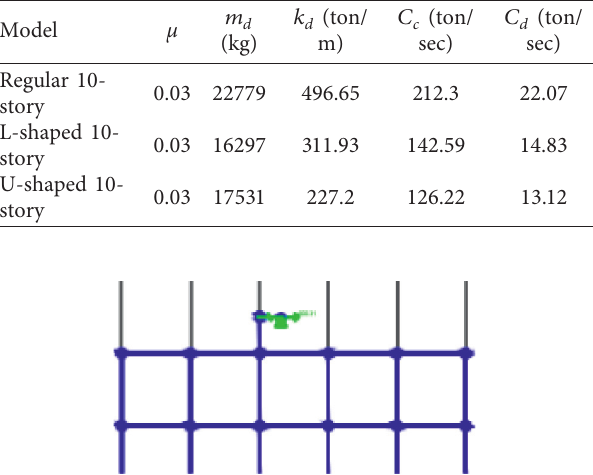
Figure 3: Mass application in the TMD